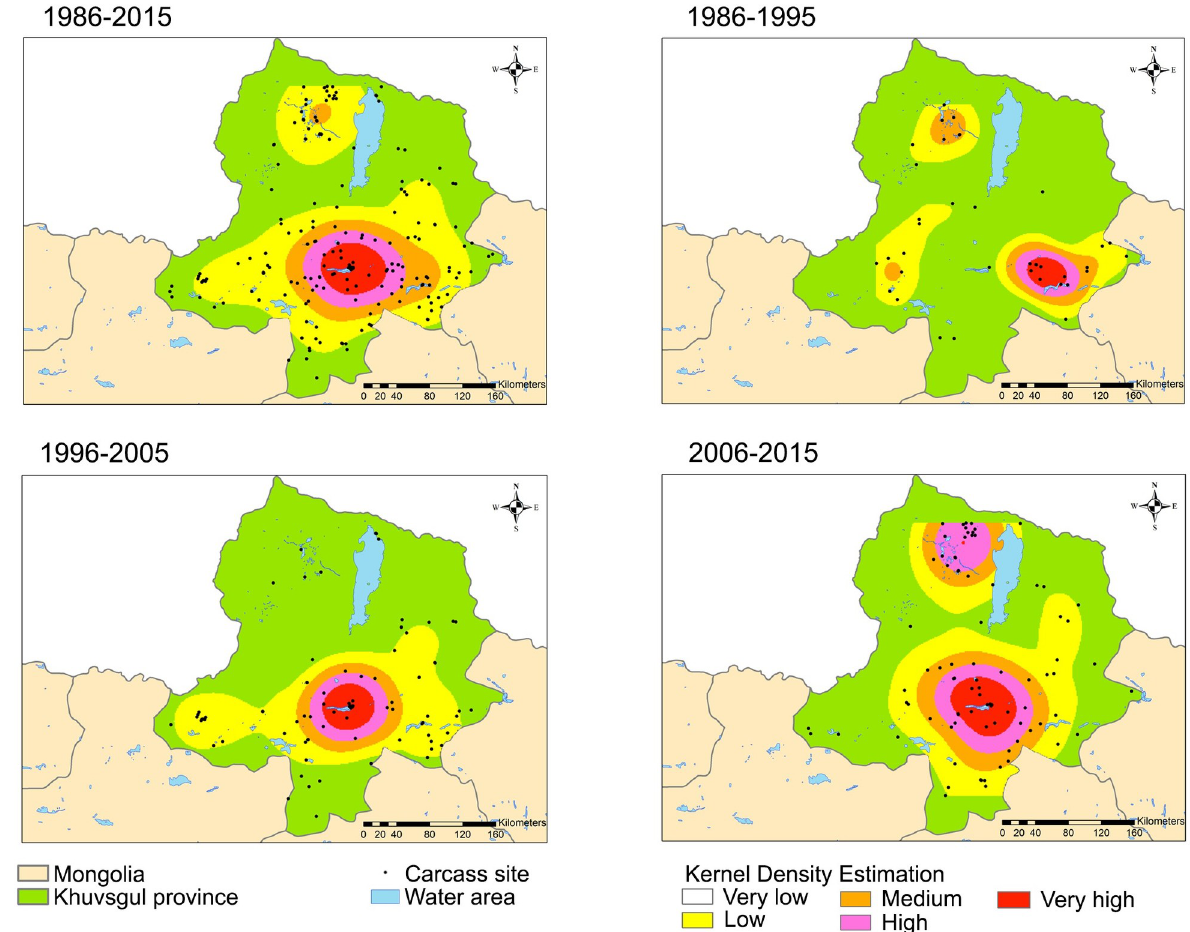
Fig 4. Hotspot analysis of carcass sites using kernel density estimation. The heat maps show the estimated density of anthrax carcass sites per square kilometer from very low (transparent) to very high (red): very low < 20%, low 40%, medium 60%, high 80%, and very high > 80% of the estimated highest values in each period. The maps are reprinted from [28] under a CC BY license, with permission from DIVA-GIS and Dr. Robert Hijmans; see S1 File.